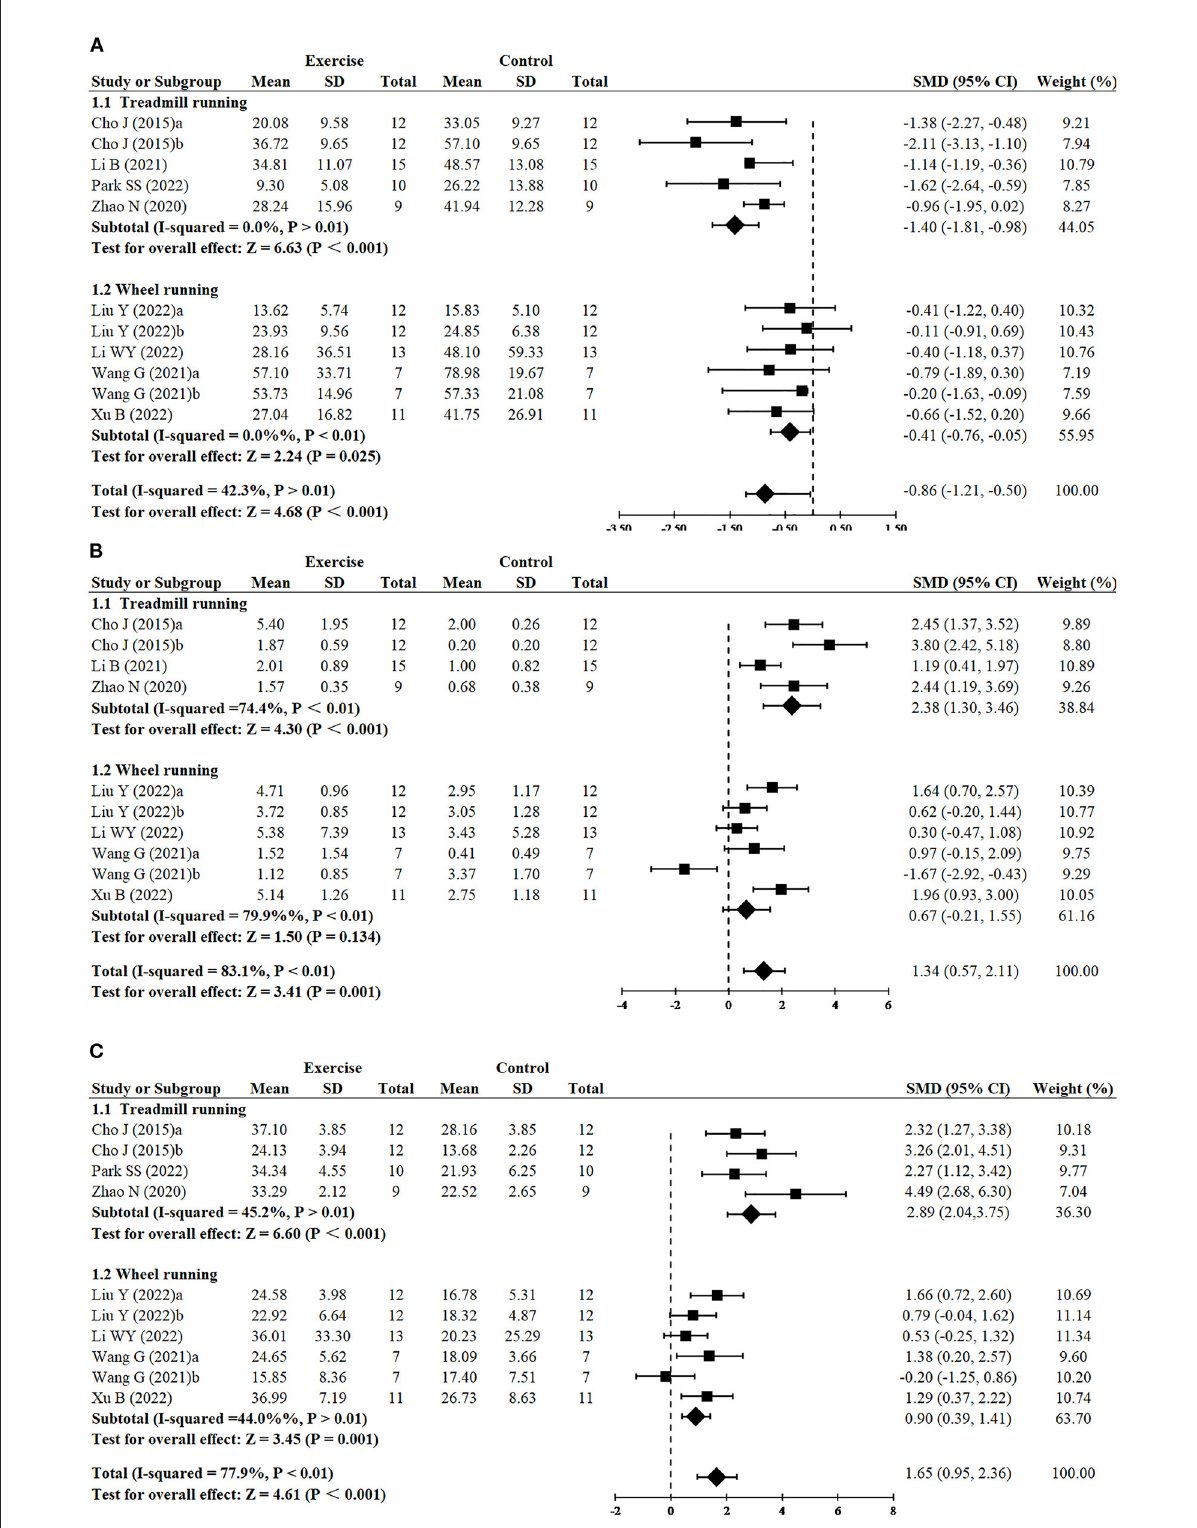
FIGURE4 Subgroup analysis of exercise type on cognitive function in AD models. (A) Subgroup analysis of exercise type on the escape latency of MWM. (B) Subgroup analysis of exercise type on the number of platform crossings of MWM. (C) Subgroup analysis of exercise type on the time in the target quadrant of